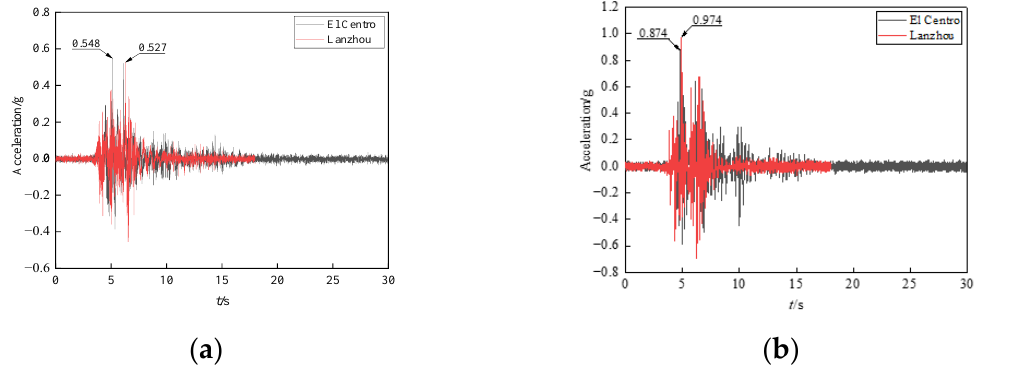
Figure 5. Acceleration response at the top of Pier 1. ( a ) X-direction; ( b ) Y-direction.